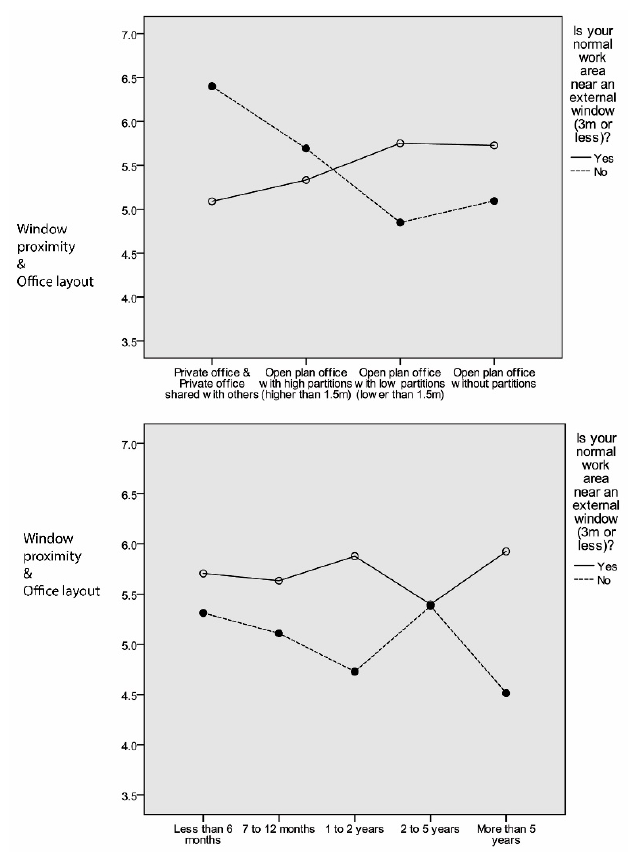
Figure 2. Two-way ANOVA results of window proximity influence on perceived productivity by office layout and working experience (4 = neither negative nor positive, 7 = very positive).